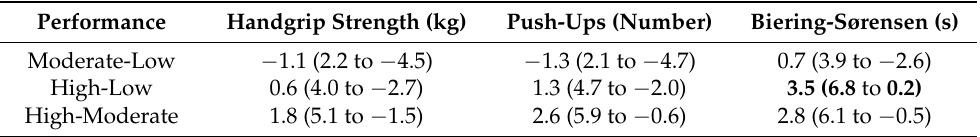
Boldface type indicates statistical